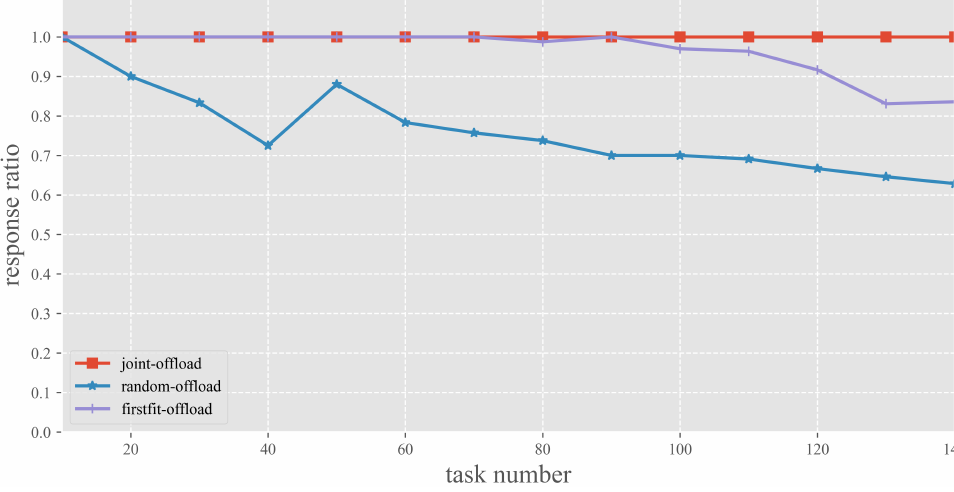
Figure 12. Task response rate of the three offloading strategies varies with the number of tasks in the whole constellation offloading